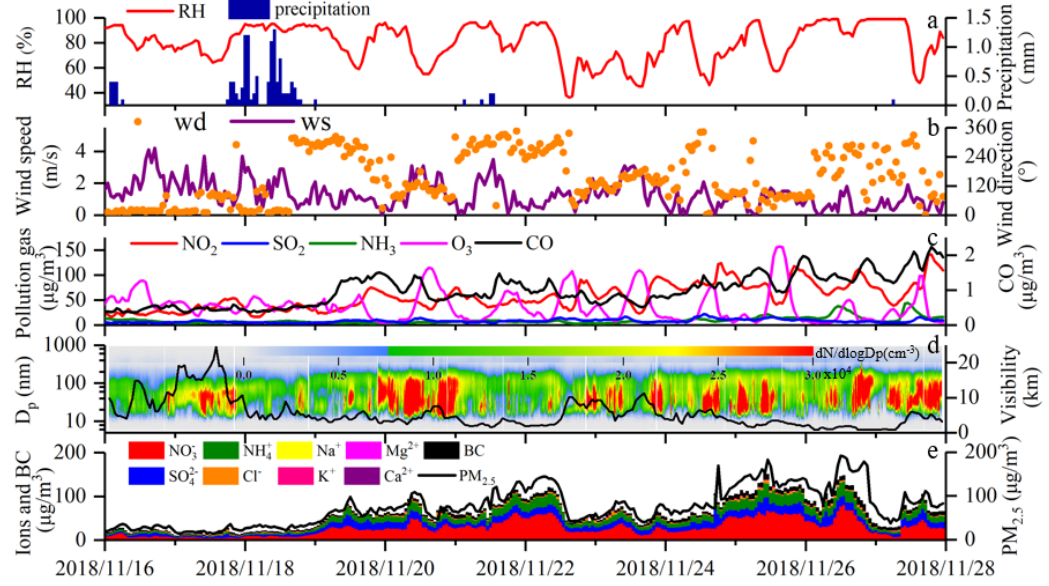
Figure 3. Time series of meteorological elements and pollutants.